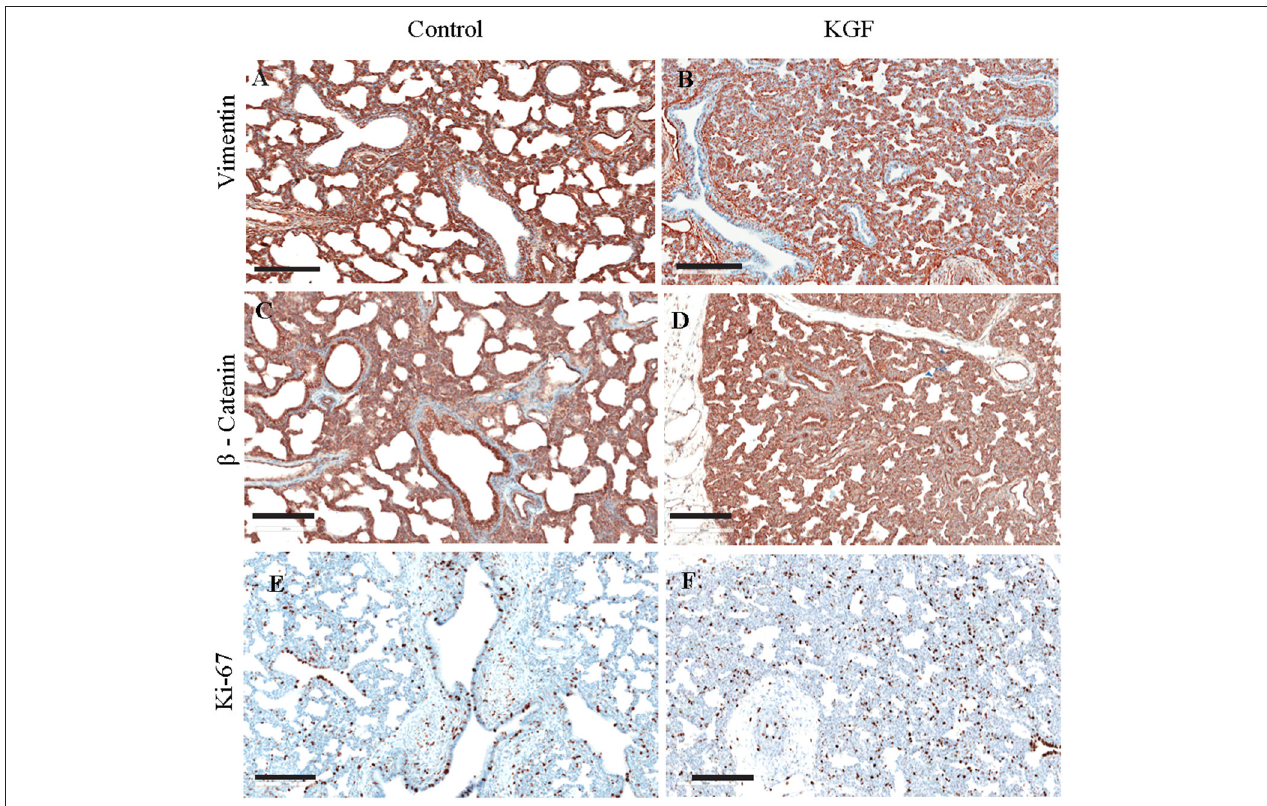
FIGURE 5 | Immunohistochemistry (IHC) performed on lung sections collected after 24 h of mechanical ventilation for other EMT markers. (A,B) Vimentin, (C,D) β - Catenin, (E,F) Ki-67 cell proliferation IHC marker. No difference between control and pretreatment with KGF. Scale bars are 200 µ m.